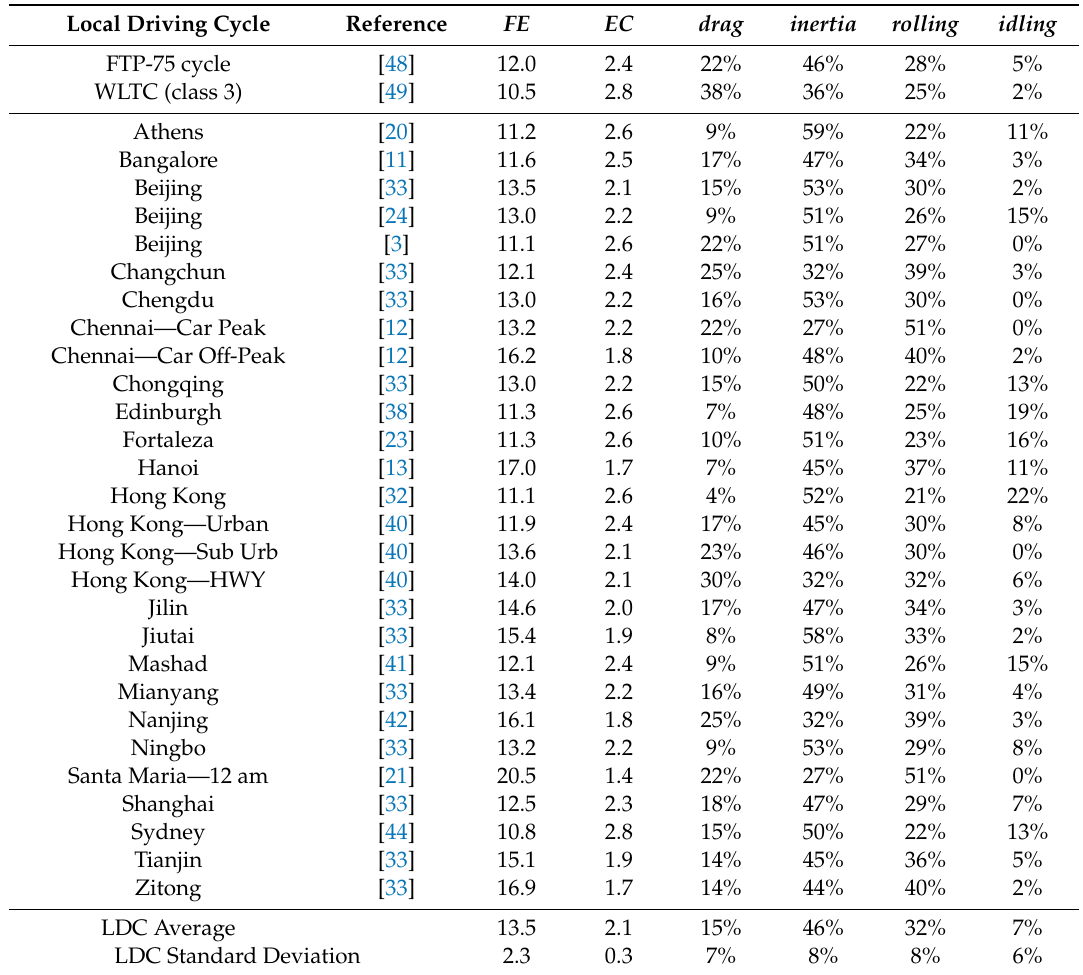
Table 9. EP ENV of the LDCs and SDCs for passenger cars.